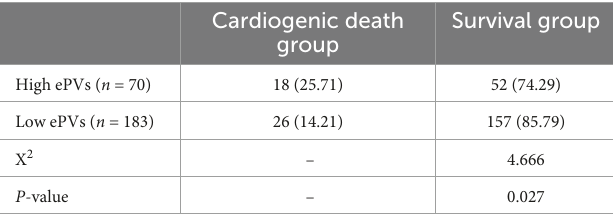
TABLE 5 One-year follow-up results of patients in the high and low estimated plasma volume status (ePVs)